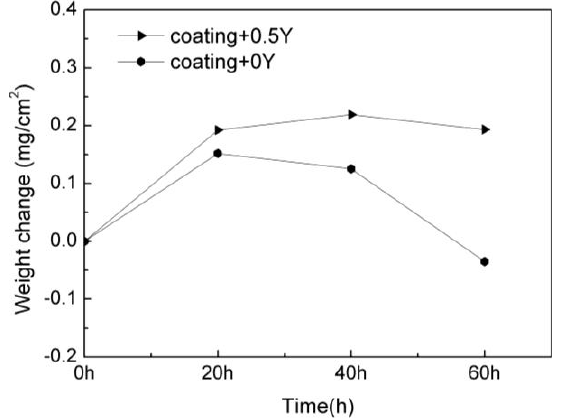
Figure 1. Corrosion kinetics of the sputtered coatings with the deposits of salt containing 95 wt.% Na SO and 5 wt.% NaCl at 900 2 4